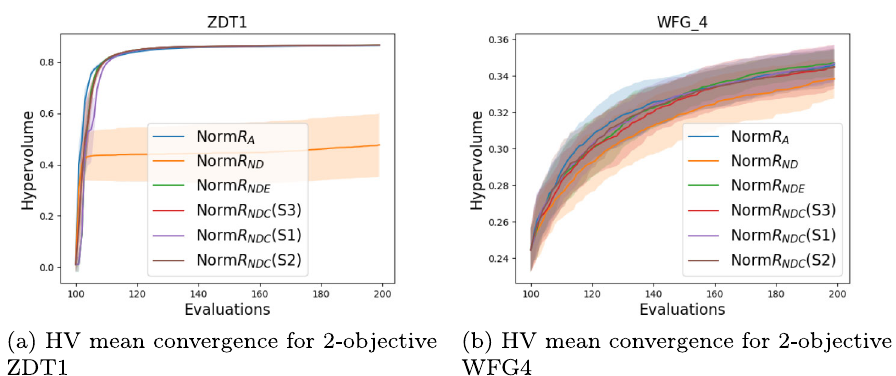
Fig. 9 Mean HV convergence for selected test problems using all